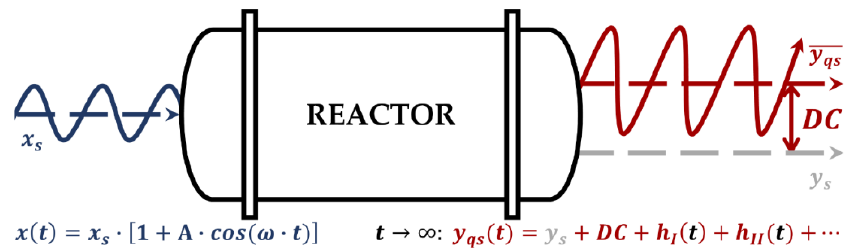
Figure 1. A schematic representation of a forced periodic (FP) operation of a chemical reactor with sinusoidal modulation of input x (blue line) and the corresponding quasi-steady-state response of the output y qs (red line).